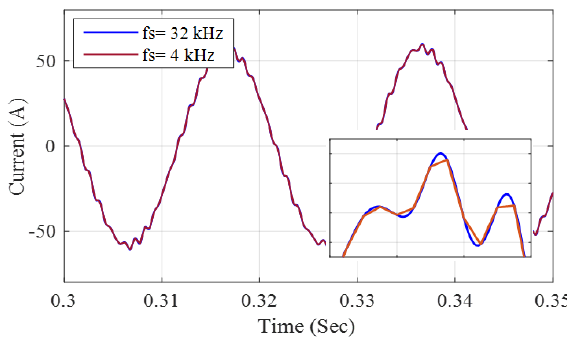
Figure 6. The estimation of intermediate solutions using data interpolation.